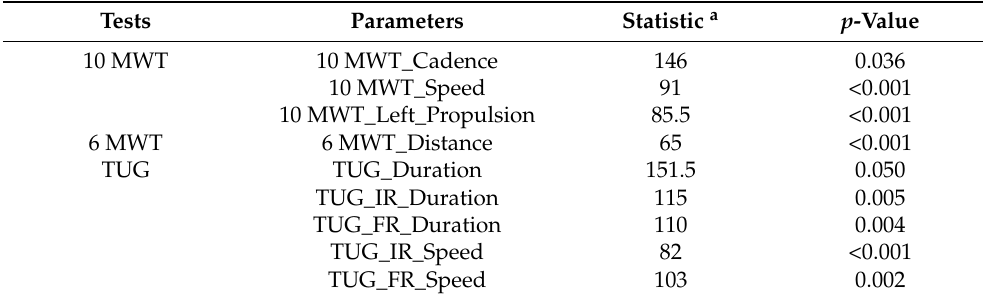
Table 4. Comparison between Able and Frail